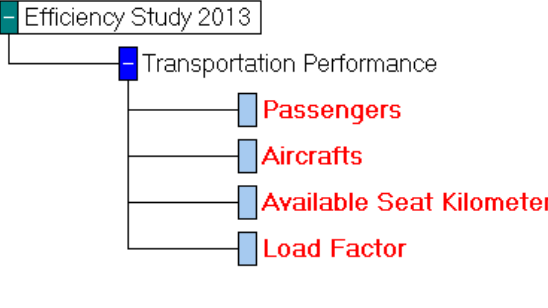
Figure 8: Table of Scores: